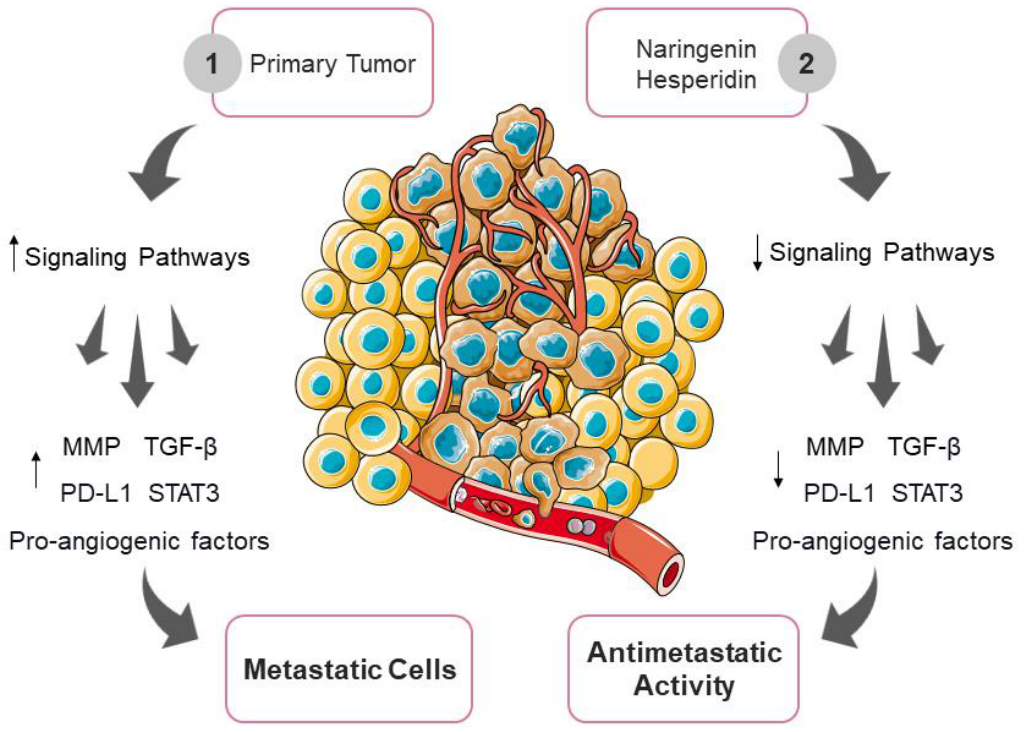
Figure 4. Antimetastatic potential of naringenin and hesperidin. (1) The primary tumor is capable of metastasis under the influence of abnormal signaling pathways, such as increased expression of activator of transcription 3 (STAT3), transforming growth factor- β (TGF- β ), pro-angiogenic factors, matrix metalloproteinases, and programmed death ligand 1 (PD-L1); (2) Administration of naringenin and hesperidin inhibited tumor cell migration by blocking these activated signals, which reverse the epithelial-mesenchymal transition (EMT) process and consequent loss of ability to